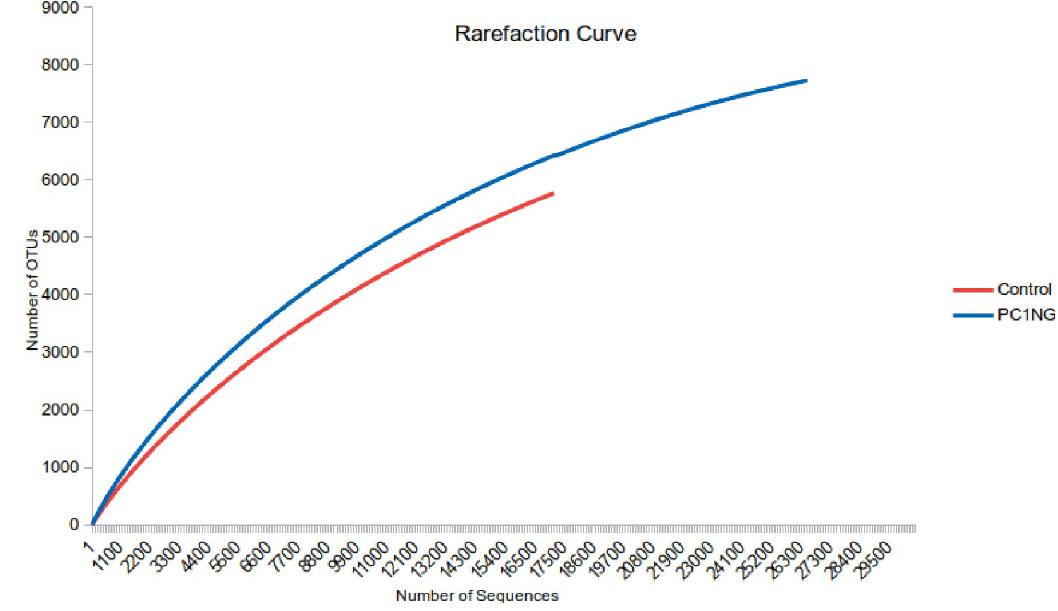
Fig 1. Rarefraction curve showing OTUs of control and treated soil sample under pot condition.